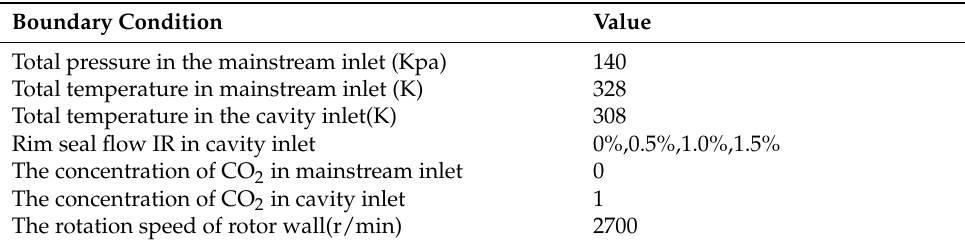
Table 2. Boundary condition [25].